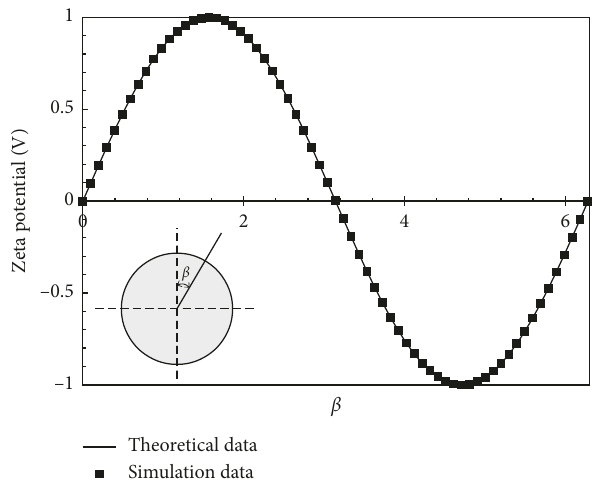
Figure 1: Zeta potential on the polarizable solid surface under the electric filed of E 0